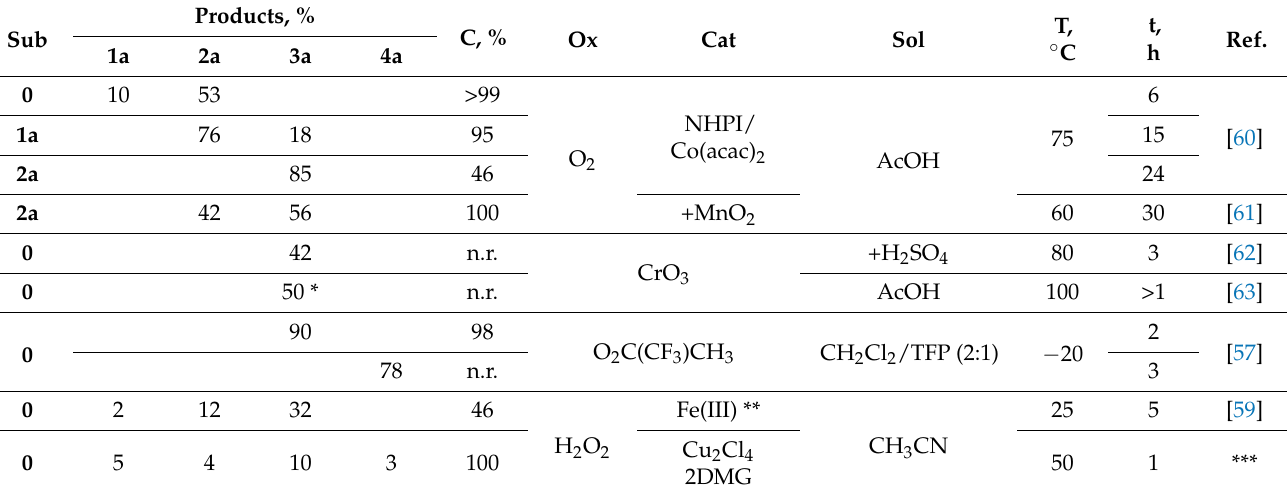
Table 3. One-stage synthesis of 3a and 4a .